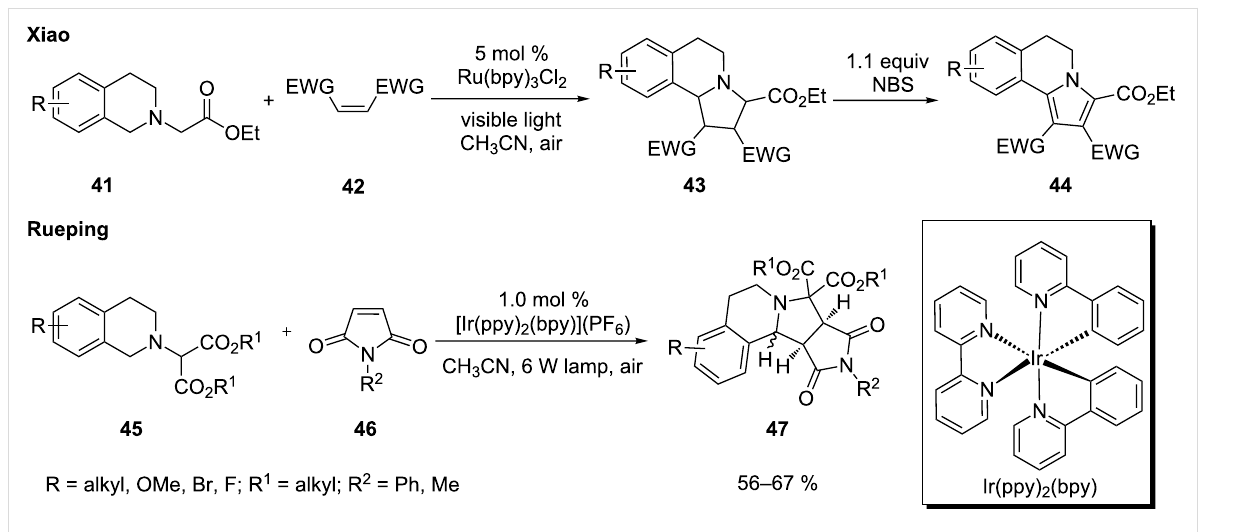
The Zhu group discovered that the use of α -ketoester 53 as a pronucleophile to intercept the iminium ion of 13 triggered a new cascade reaction en route to fused isoxazolidine 54